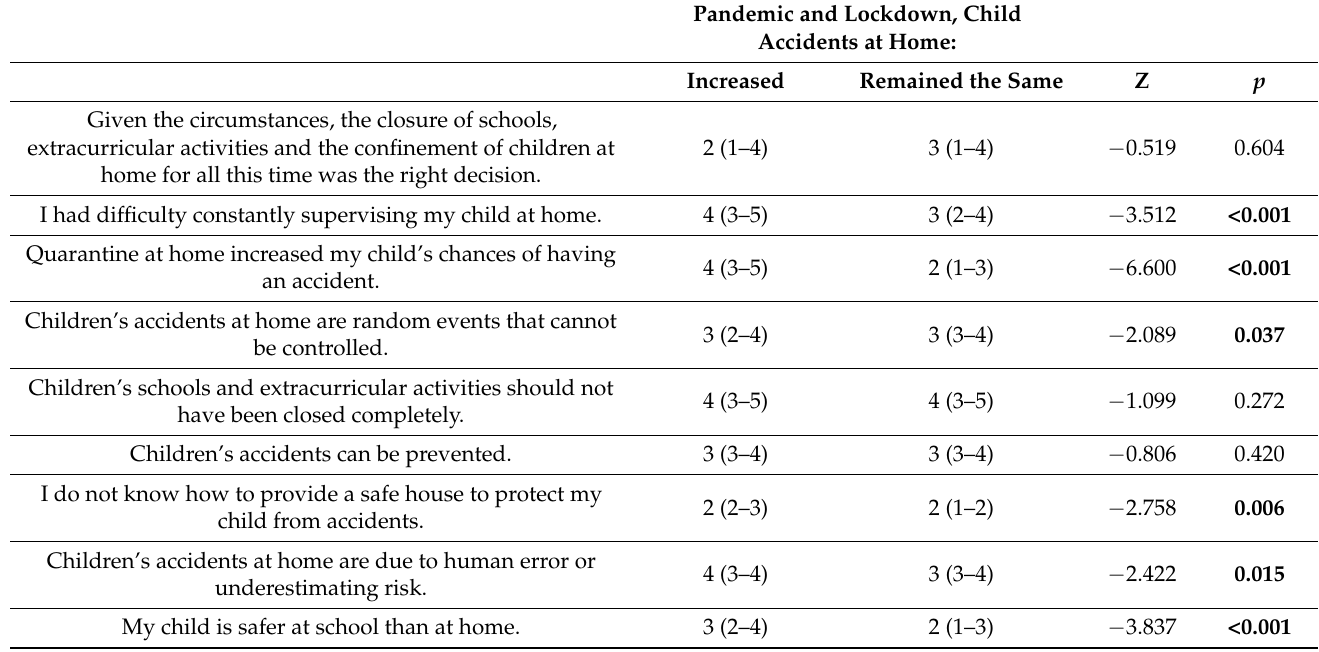
Table 3. Comparison between the question, “Do you think that, during the pandemic and lockdown, child accidents at home:” and the parents’ perceptions about children’s accidents. Do You Think That, during the Pandemic and Lockdown, Child Accidents at Home: Increased Remained the Same Z p